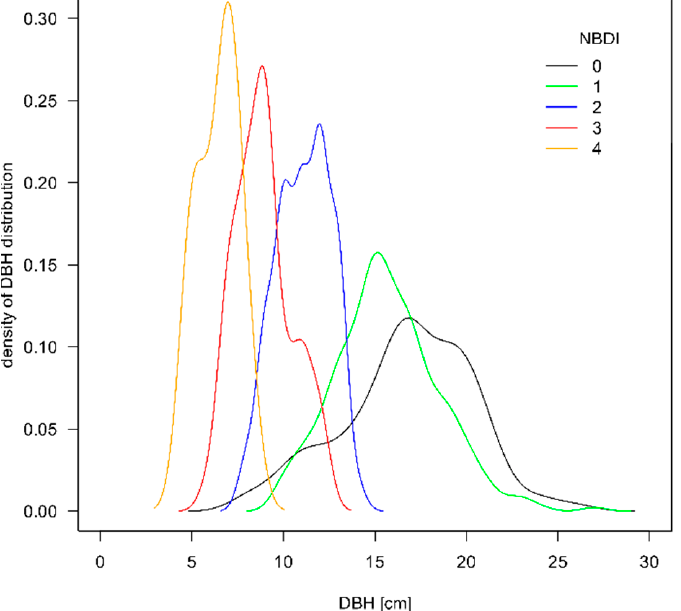
Figure 3. Density of diameter breast height (DBH) distribution in relation to the number of bark damage instances (NBDI) on the tree.